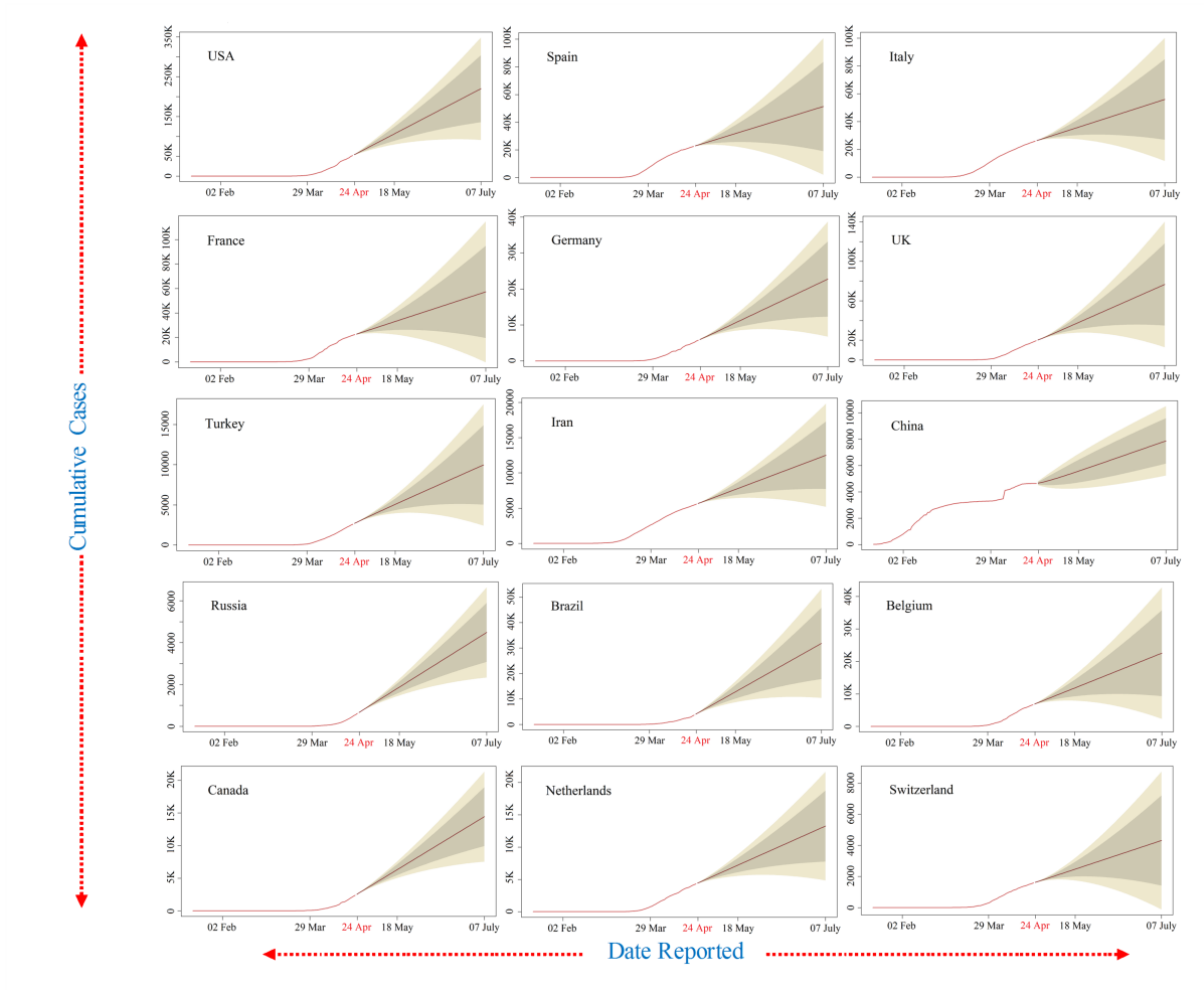
Figure 4. The autoregressive integrated moving average model prediction for more than 2 months of cumulative confirmed coronavirus disease cases in the top 15 affected countries shown in a brown color (95%